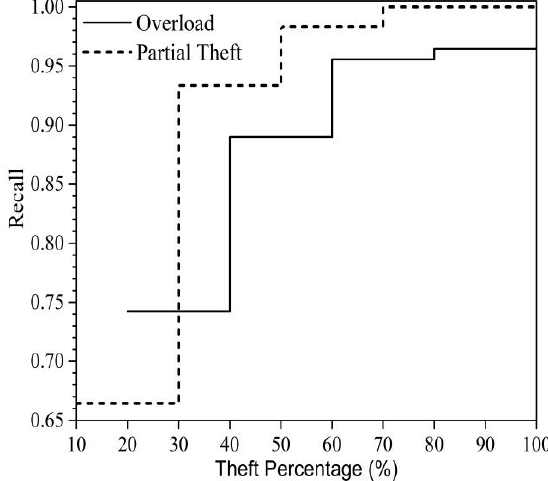
Figure 11. Recall metric for partial power theft and overload scenarios.